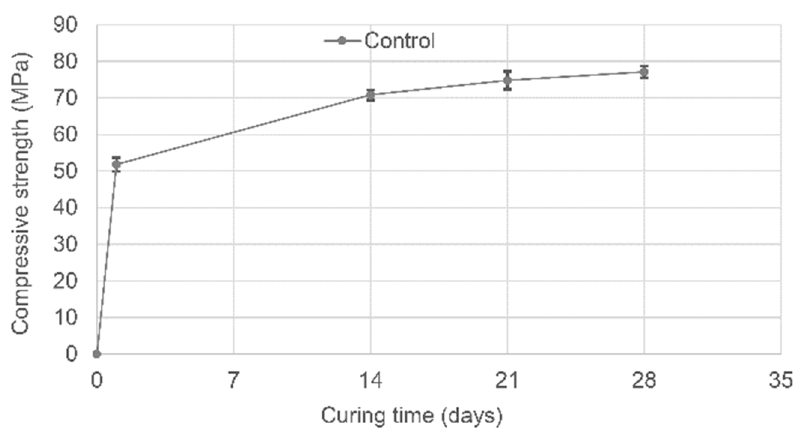
Figure 4. Concrete compressive strength variation with time.